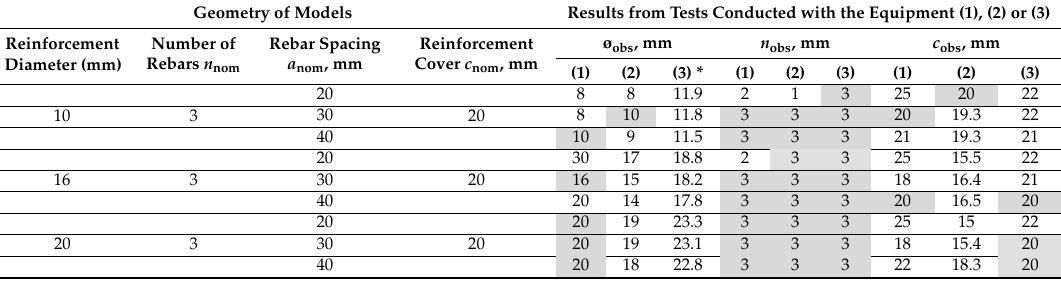
Table 3. Test results for lightweight concrete specimens (at constant cover thickness of 20 mm).